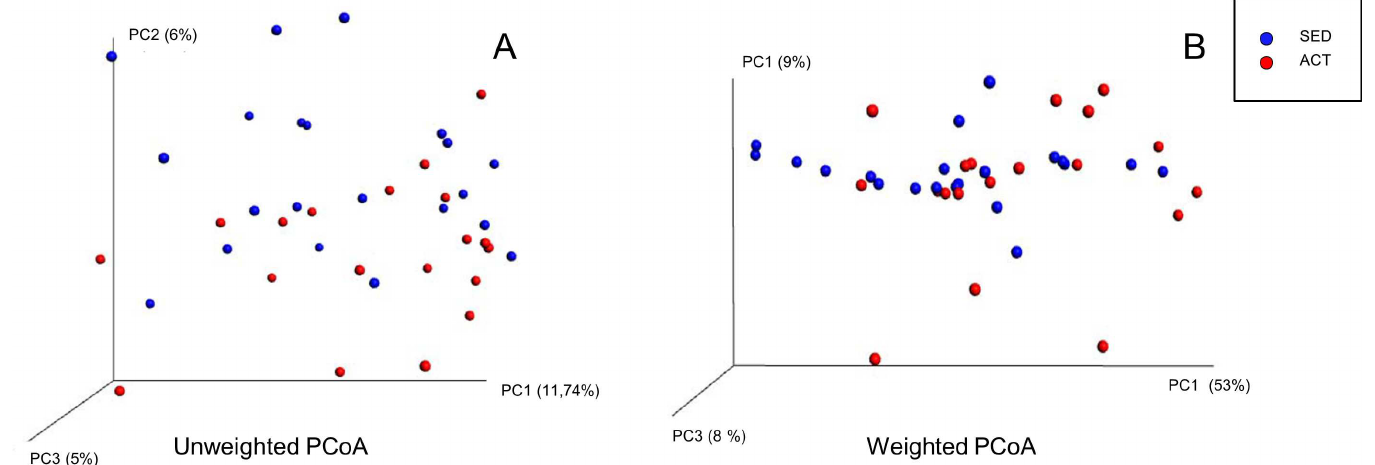
Fig 1. Principal Coordinates Analysis (PcoA) plots of unweighted (A) and weighted (B) Unifrac distance metricsobtained from sequencing the 16s rRNA gene in fecal samples . Axes represent percentage of data explained by each coordinate